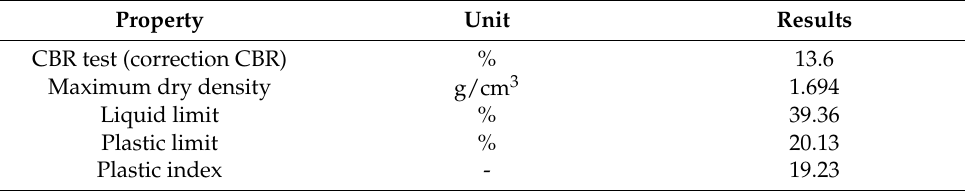
Table 1. Evaluation results for the basic properties of the stone sludge.